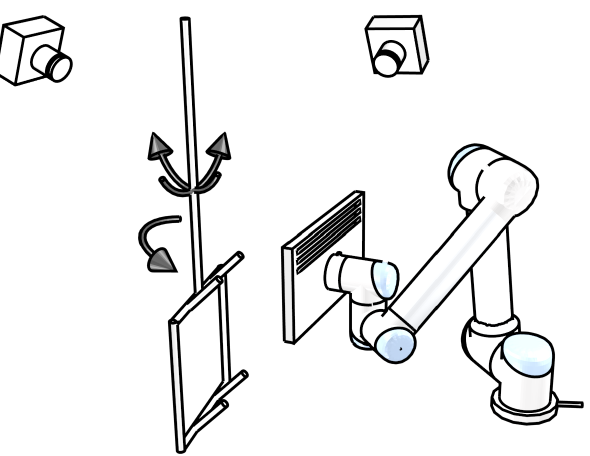
Figure 1: Manual loading of objects onto a swinging conveyor trolley is a common task in indus- try. The proposed automatic solution is to control the trajectory of the robot manipu- lator in real-time using an estimate of the trolley motion. An estimate of the trolley motion is found using particle filter based vi- sual